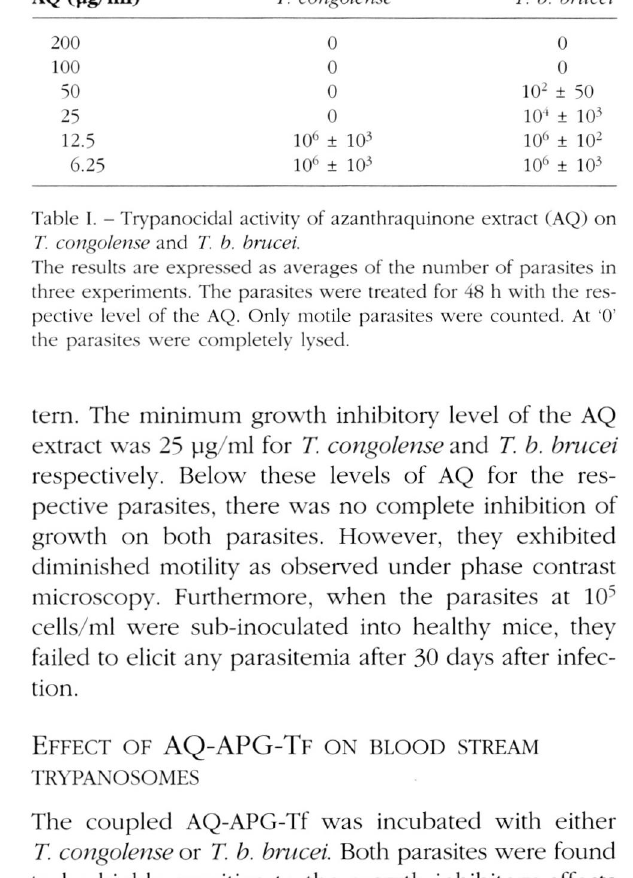
Table III. - a-mannosidase activity in extracts of AQ-APG-Tf treated parasites. The results are expressed as averages of three